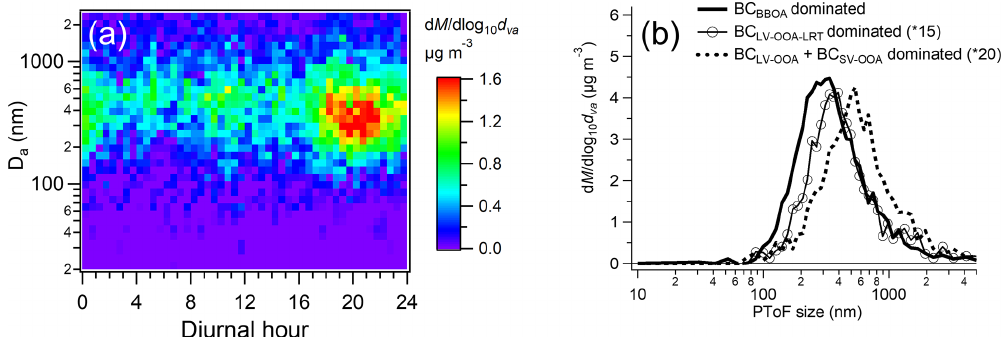
Figure 3. Mass size distribution of BC in the residential area. The evolution of mass size distributions during the day (a) and the examples of the mass size distribution during the periods when BC BBOA , BC LV-OOA-LRT , or the sum of BC LV-OOA and BC SV-OOA dominated total BC concentration (b) . Data for (a) were collected from 16 January to 28 February 2019 when there were intensive biomass burning episodes. The BC BBOA period in (b) was measured on 22 January 2019 from 19:45 to 23:30LT, the BC LV-OOA-LRT period from 4 April 2019 at 03:45LT to 5 April 2019 at 23:30LT, and the BC LV-OOA + BC SV-OOA period from 17 March to 1 April